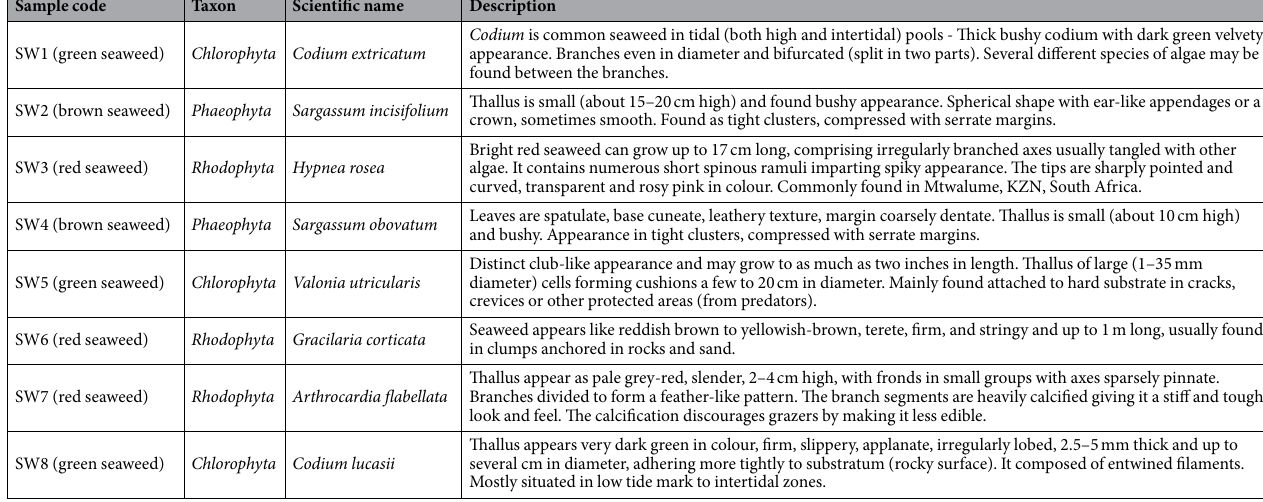
Table 2. Sample code, Taxonomy, Scientific name and its description of collected